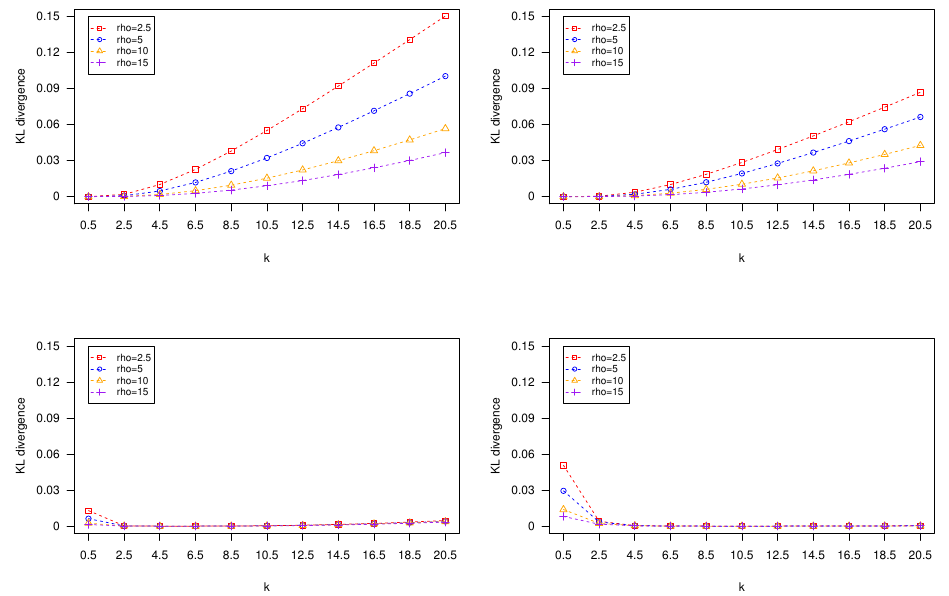
Figure 2. Maximum Kullback Leibler divergence between the univariate generalized Waring ( UGW ) ( a , k , ρ ) distribution and the EBW ( to right).